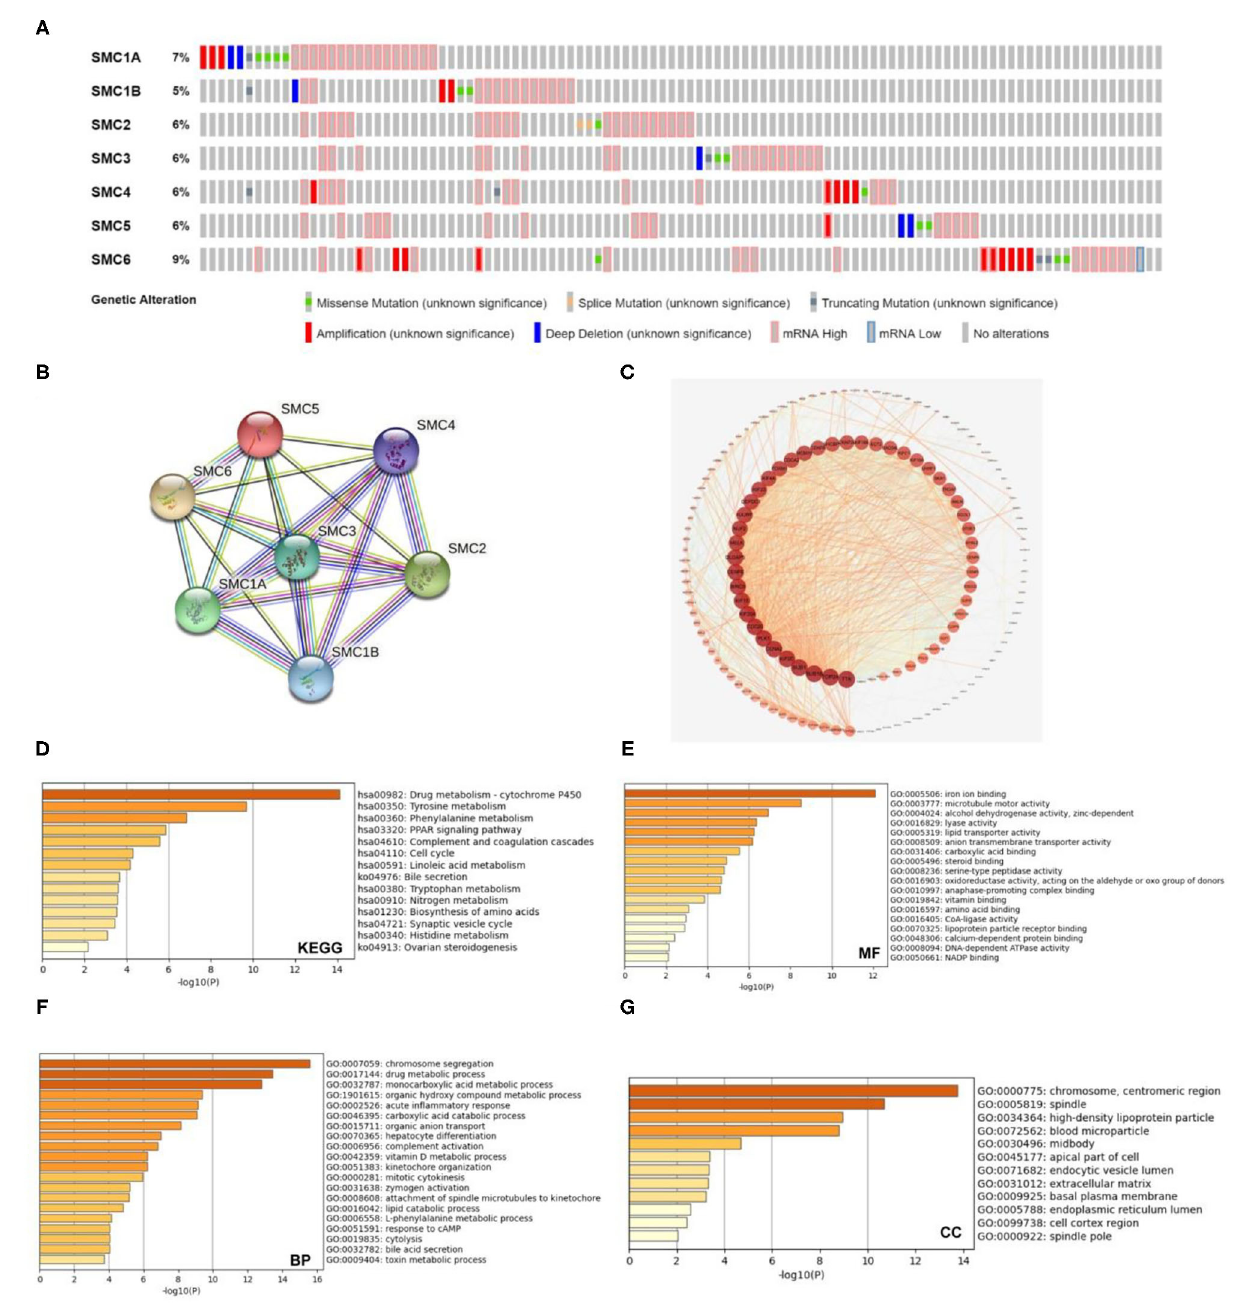
FIGURE 6 | Genetic alterations and pathway enrichment analysis of SMC family in HCC. (A) The genetic alteration of SMC1A , SMC1B , SMC2 , SMC3 , SMC4 , SMC5 , and SMC6 in HCC was illustrated from top to bottom. (B) The SMC family members interaction analysis was evaluated by STRING database. (C) Construction a network of genes co-expressed with SMC family members in HCC. (D-G) The KEGG enrichment pathway, Molecular functions, biological processes, and cell components of co-expressed genes was analyzed by Metascape database.